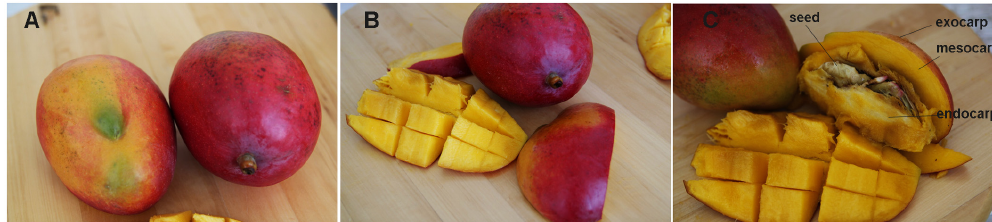
Figure 1. Features of the different mango fruit fractions. The fruits with a thin and colourful peel ( A ); and a yellowish-orange edible flesh ( B ) are shown; ( C ) Details of different mango fractions are reported, illustrating the outer peel (exocarp), the edible pulp (mesocarp) and the stony pit (endocarp) enclosing a large seed inside.